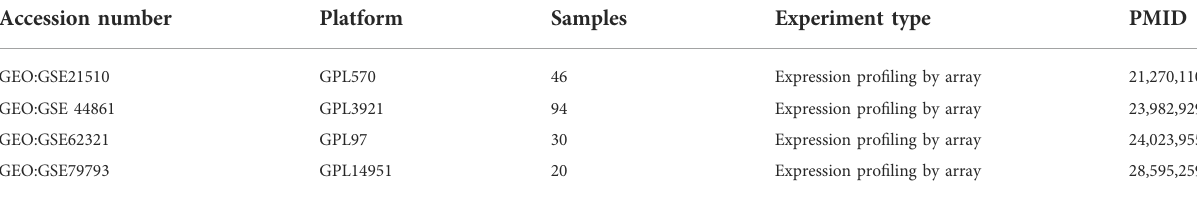
TABLE 1 The information of datasets from the GEO